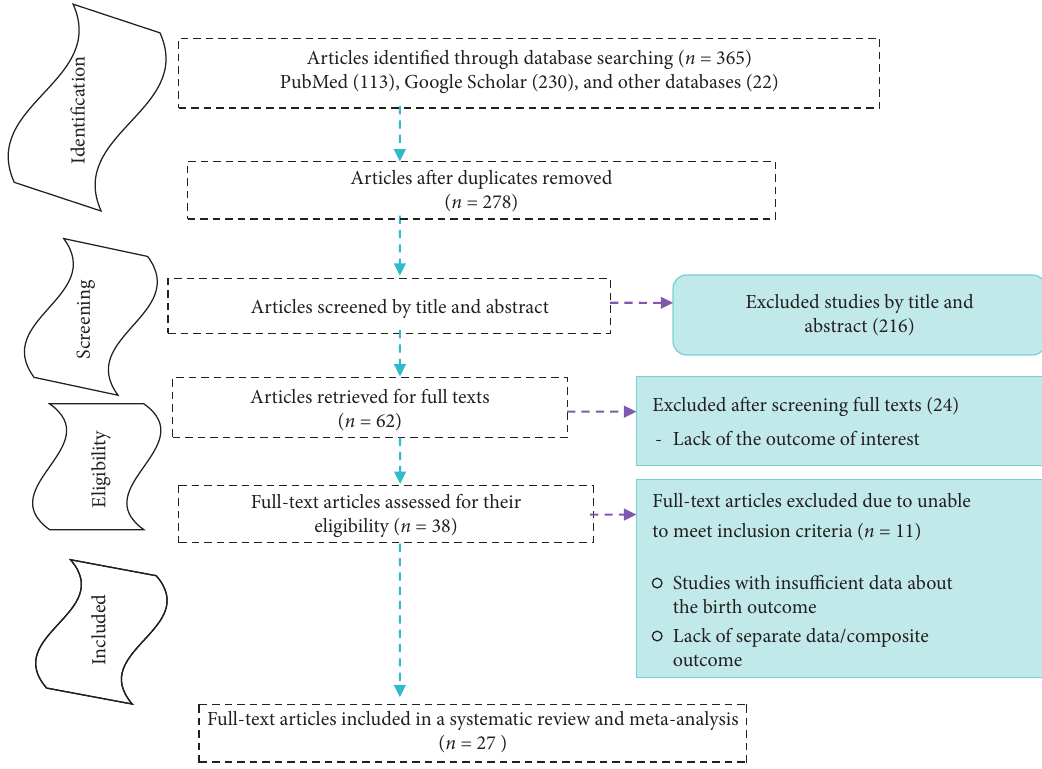
Figure 1: Study selection flow diagram, a figure adapted from the PRISMA group